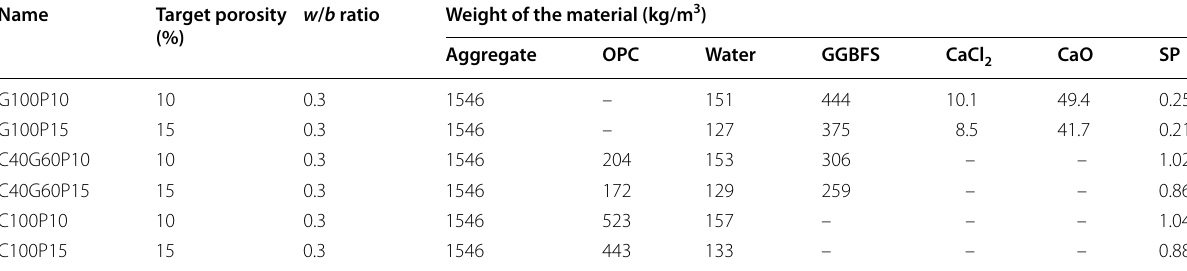
Table 2 Mix proportions of the tested pervious concretes.